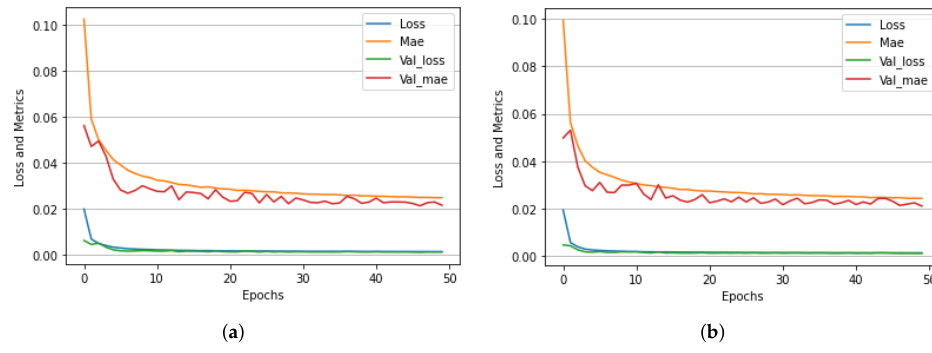
Figure 3. Training performance of both neural networks. ( a ) LSTM NN; ( b ) GRU NN.